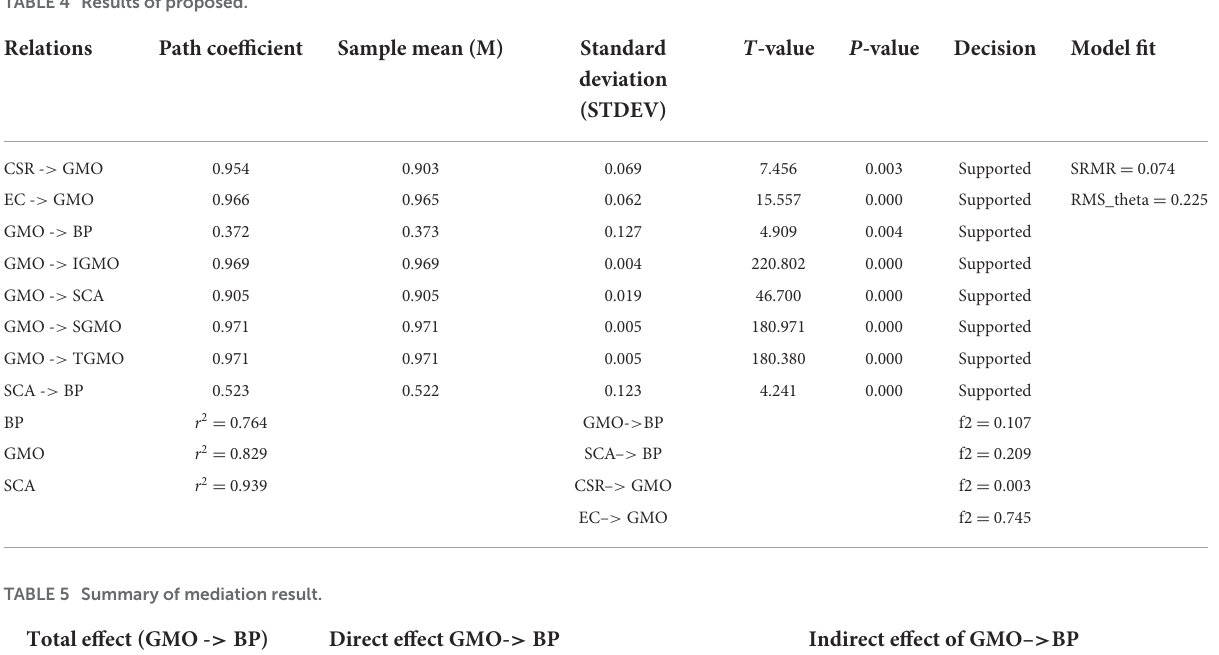
TABLE 4 Results of proposed.